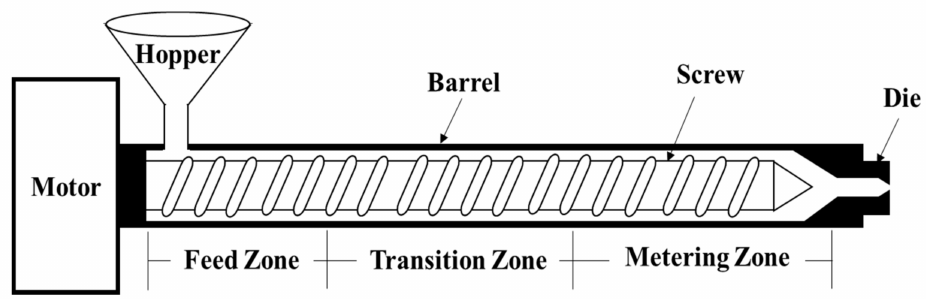
Figure 3. A layout of filament fabrication